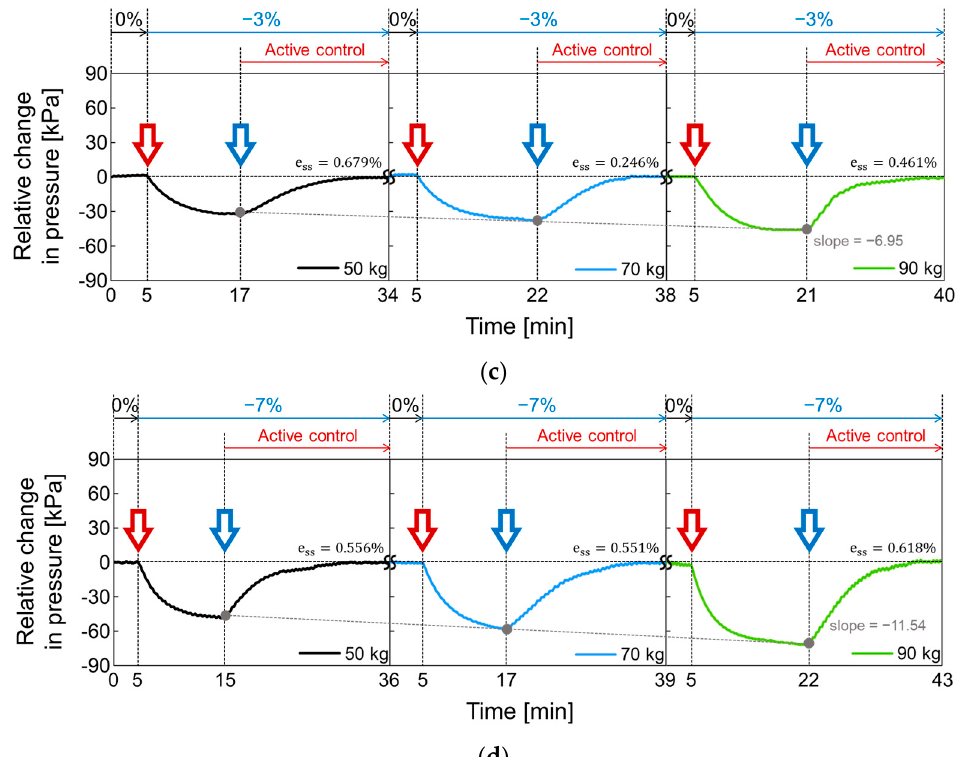
Figure 18. The active volume compensation of the proposed socket when the weight is 50, 70 and 90 kg and the limb volume changes ( a ) from 0% to +3%; ( b ) from 0% to +7%; ( c ) from 0% to -3%; ( d ) from 0% to -7%.